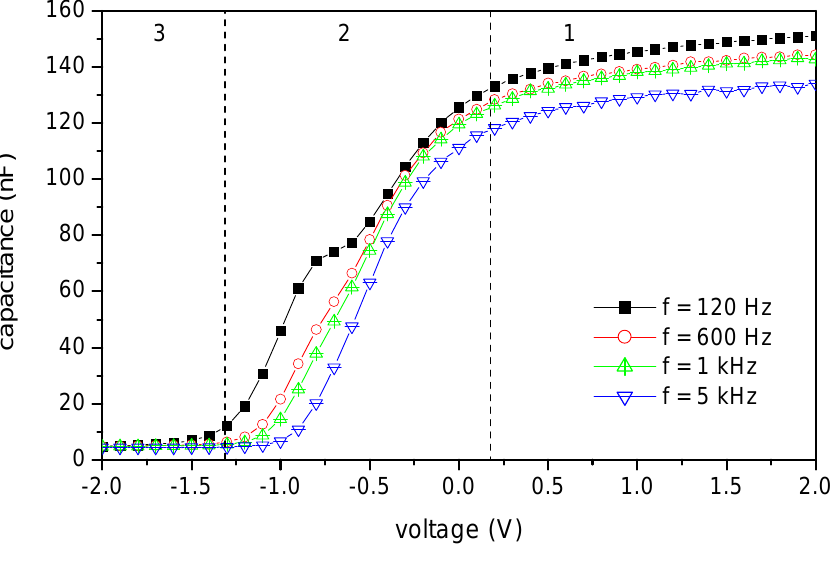
Figure 4. Characteristic C/V measurement of a pH sensor (S1), etched with a current density of 30 mA/cm 2 in the frequency range between 120 Hz and 5 kHz. A frequency of 1 kHz has been found as optimal for C/V and ConCap